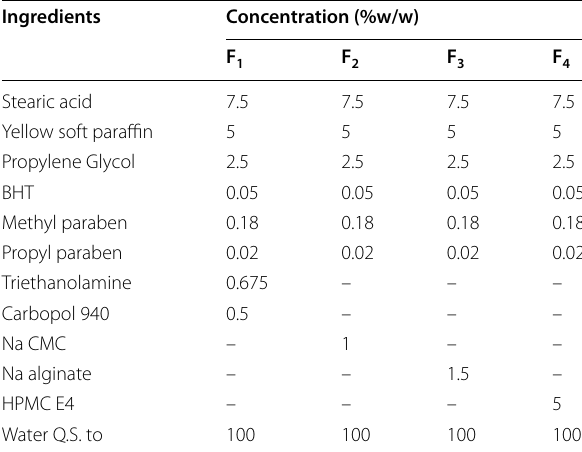
Table 1 Composition of different plain emulgel